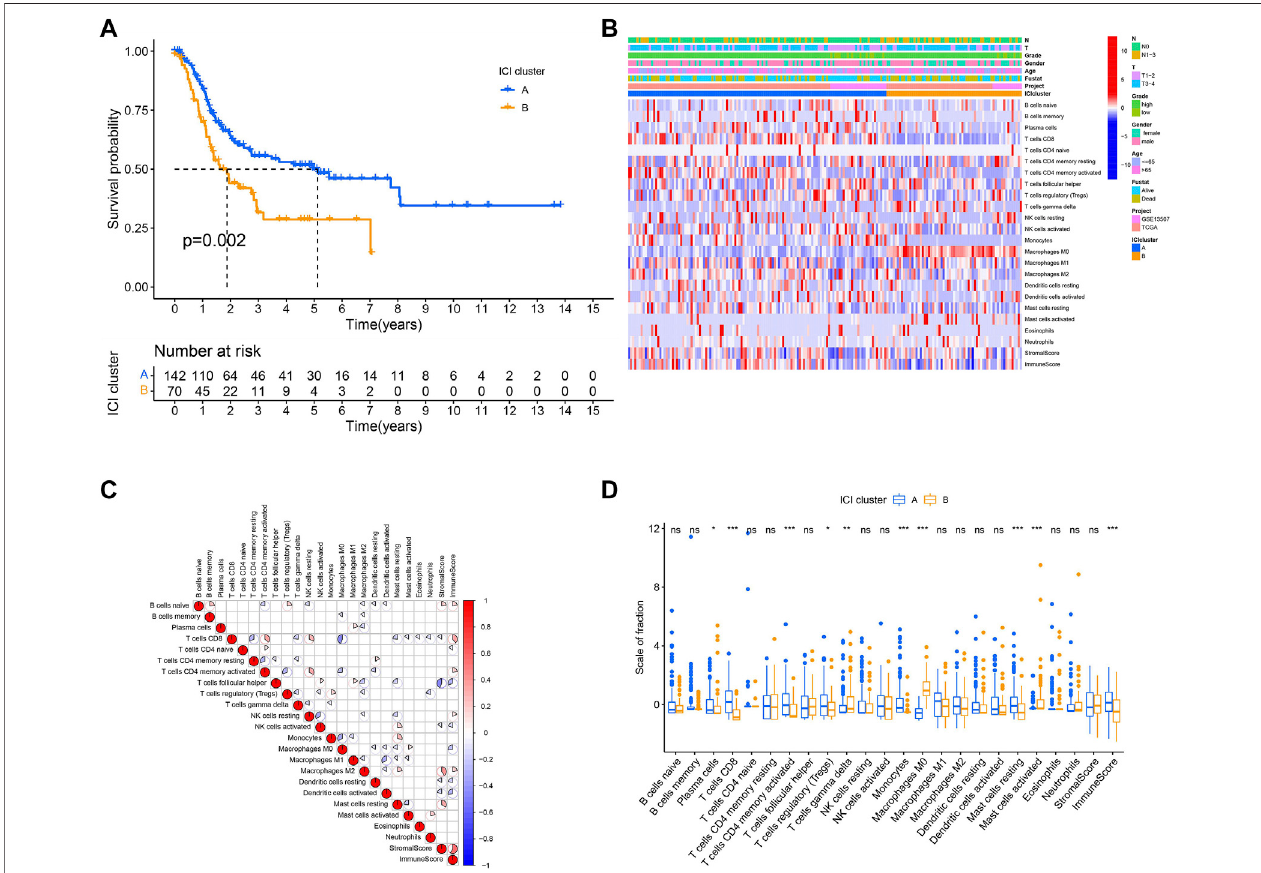
FIGURE3| ThepatternofICIintheTMEofBLCA. (A) SurvivaltimeofpatientsintwoindependentICIsubtypes. (B) Visualizedtheexpressionlevelsofimmunecells of distinct ICI clusters. (C) The correlation among different immune cells. (D) The proportion of tumor-in fi ltrating immune cells in two ICI clusters. We also depicted the immune score and stromal score of two ICI clusters. * p < 0.05; ** p < 0.01; *** p <